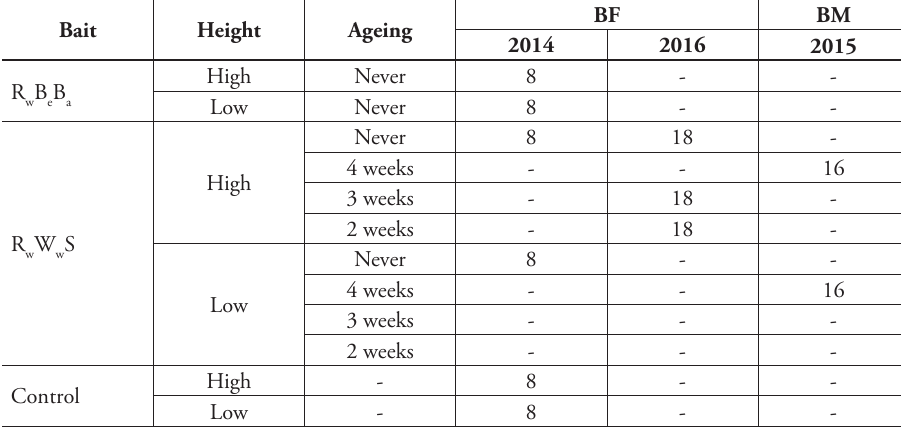
Table 2. Overview of the trap sample and number of traps set in the two study areas, Bosco della Fontana (BF) and Bosco della Mesola (BM), during the three years of monitoring. Baits: R Banana); R W S (Red Wine, White Wine, Sugar); Control (empty traps used as control). Height at which w w traps were set: High (above 10 m), Low (1.5–2.0 m). Variation in ageing of the mixture: Never